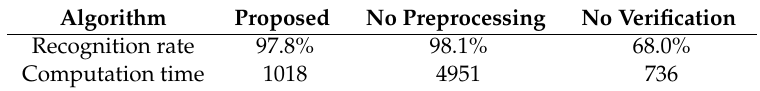
Table 4. Contribution of scene preprocessing and pose verification on all 13 of the objects.